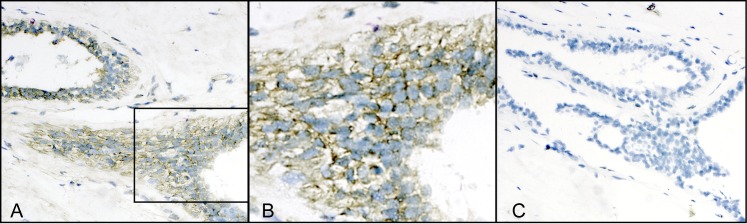
Bovine leukemia virus (BLV) in the mammary epithelium of a donor with breast cancer.(A) BLV DNA detected by in situ PCR (brown cells) (X40). Note presence of brown outcome reaction only in epithelium and not in surrounding connective tissue; (B) enlargement of boxed area in A, showing that the positive reaction is localized to the cytoplasm of mammary epithelial cells (X136). (C) background control, adjacent section reacted with PCR mix without primers to rule out non-specific false positive reactions (X40). Note absence of brown outcome reaction. Counterstain for A,B, and C is Difquick blue.